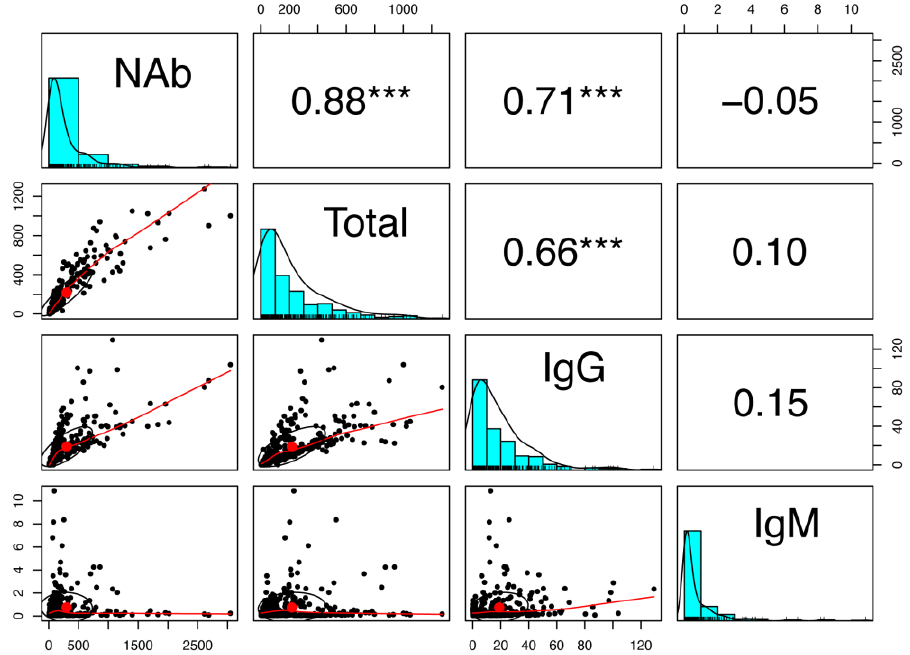
Figure 3. Correlation between anti-SARS-CoV-2 IgM levels and the other three antibodies. Each dot represents the antibodies in one individual at each time point ( n = 608). ***, significant at the 0.001 probability level. Abbreviations: NAb: anti-SARS-CoV-2 neutralizing antibodies; Total: anti-SARS-CoV-2 total antibodies; IgG: anti-SARS-CoV-2 IgG antibodies; IgM: anti-SARS-CoV-2 IgM antibodies.